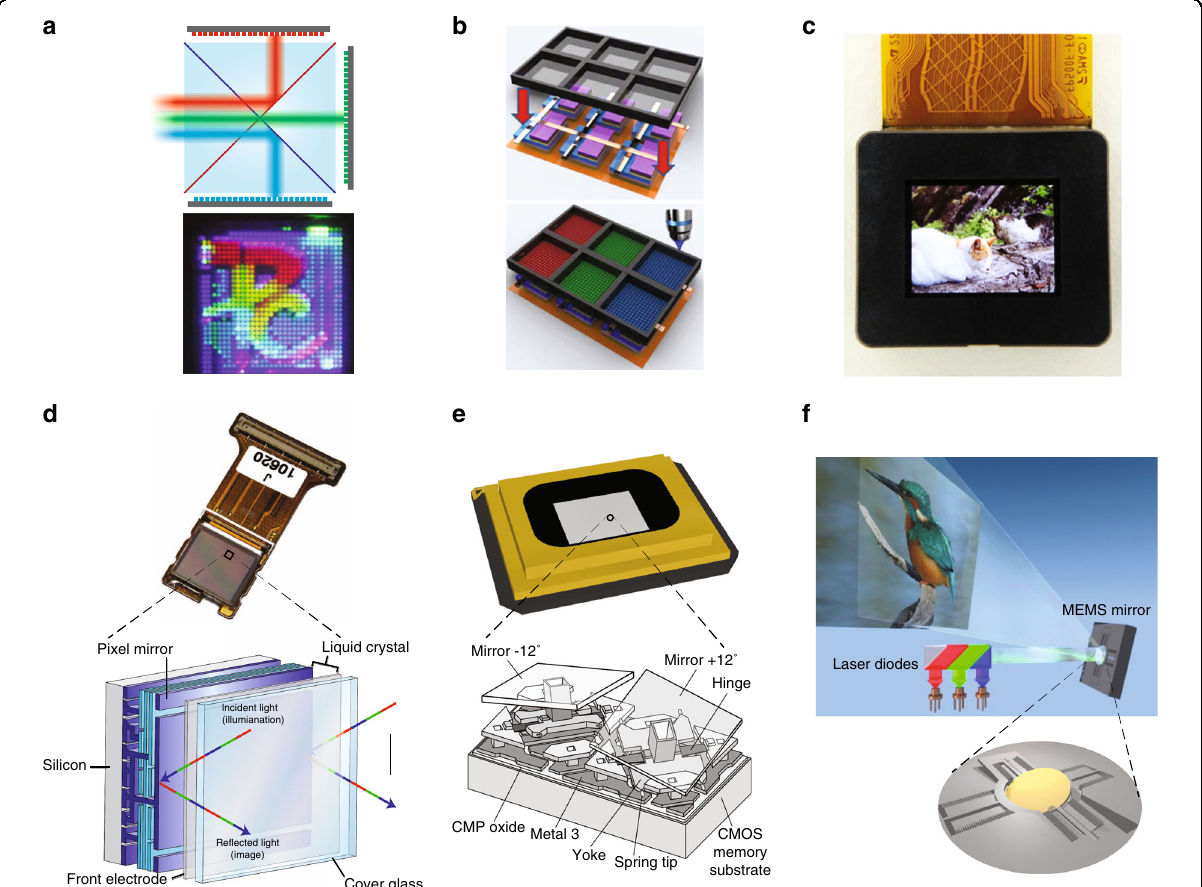
Fig. 7 Different types of light engines in AR displays. a RGB micro-LED microdisplays combined by a trichroic prism. b QD-based micro-LED microdisplay. c Micro-OLED display with 4032 PPI. Working principles of d LCoS, e DMD, and f MEMS-LBS display modules. Reprinted from a ref. 106 with permission from IEEE, b ref. 108 with permission from Chinese Laser Press, c ref. 121 with permission from Jon Wiley and Sons, d ref. 124 with permission from Spring Nature, e ref. 126 with permission from Springer and f ref. 128 under the Creative Commons Attribution 4.0